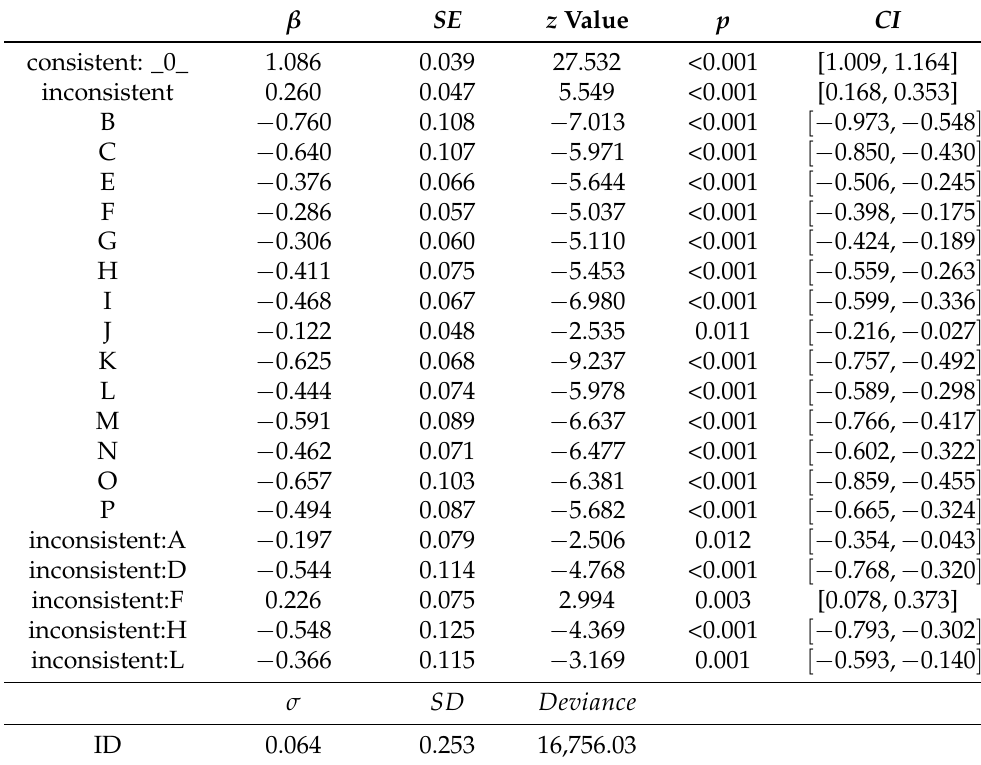
Table A3. Mixed model of the influence of binary stimuli conditions on the emospace widget response.